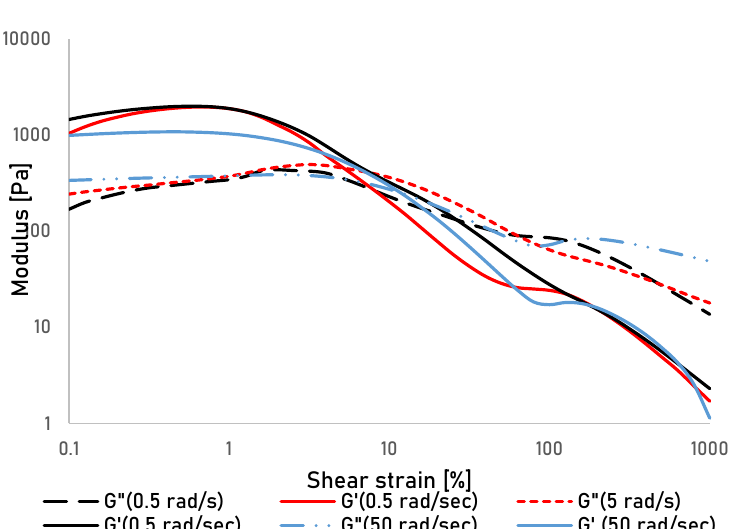
Figure 3. Storage (G') and Loss (G") modulus of a presheared cellulose gel over shear strain measured at angular frequencies of 0.5, 5 and 50 rad/sec.